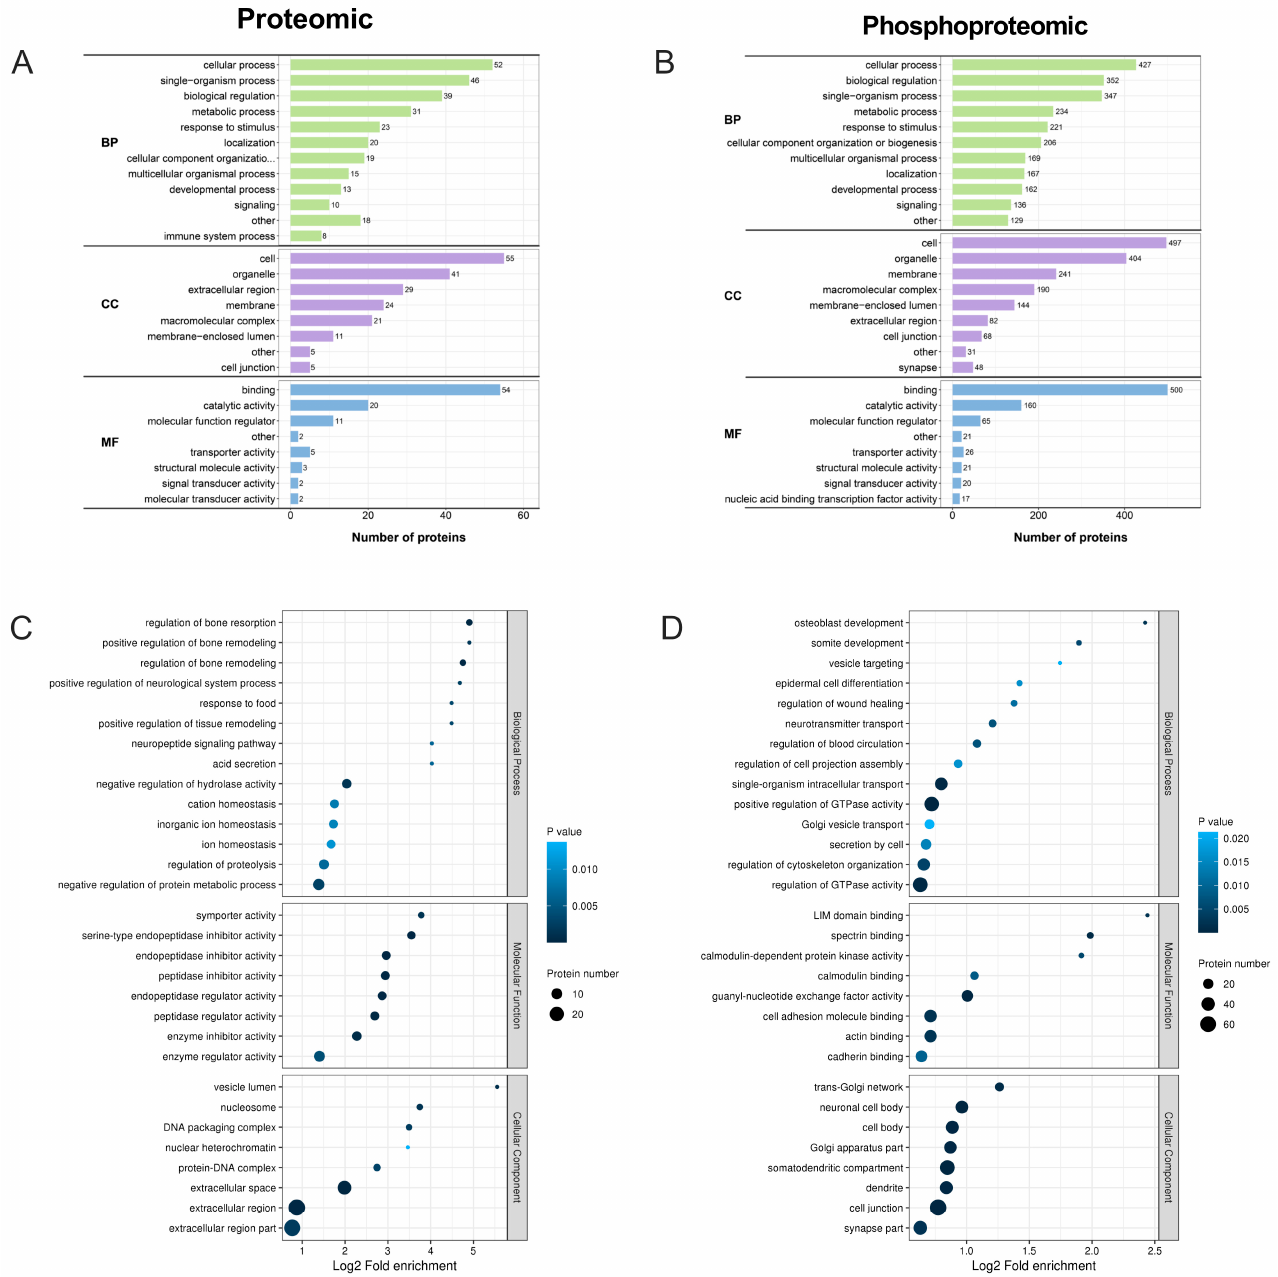
Figure 5. GO functional enrichment analysis of DEPs and DEPPs. ( A , B ) GO categories of the DEPs and DEPPs. ( C , D ) Bubble charts of enrichment distributions of DEPs ( C ) and DEPPs ( D ) in GO functional classification.